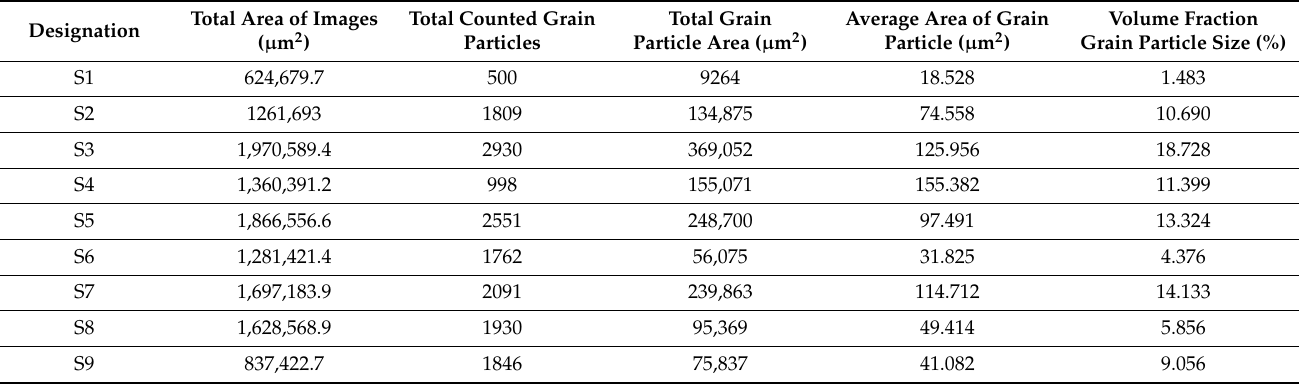
Table 5. Determination of volume fraction of grain particles in the composite.